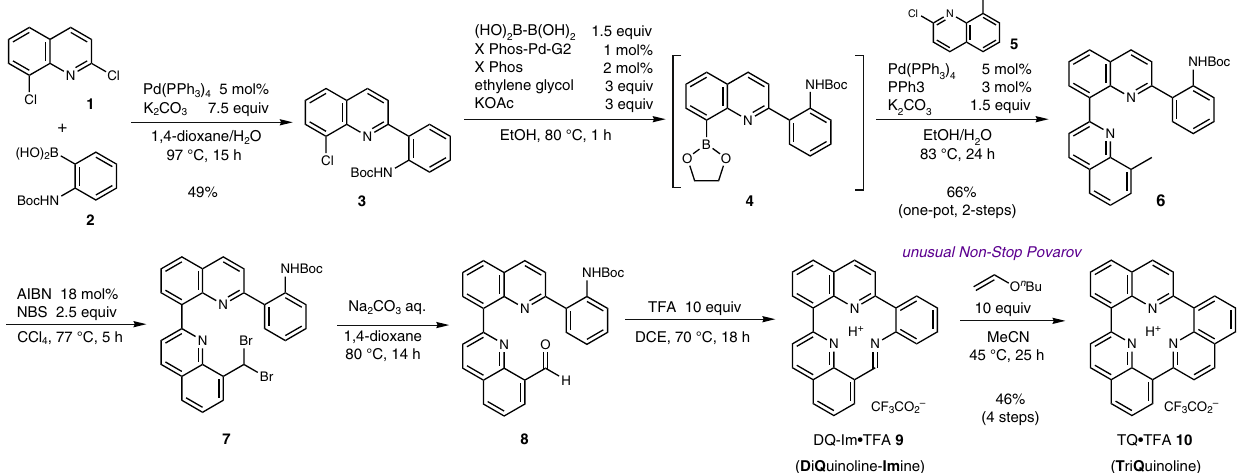
Fig. 2 Synthesis of TQ: TriQuinoline. Puri fi cation was performed at stages 3 and 6 . The fi nal step represents the unusual Povarov reaction, in which plausible tetrahydro- and dihydroquinoline intermediates were undetectable, furnishing the TQ architecture without the need for additional elimination and oxidation conditions. AIBN azobisisobutyronitrile, NBS N -bromosuccinimide, TFA tri fl uoracetic acid